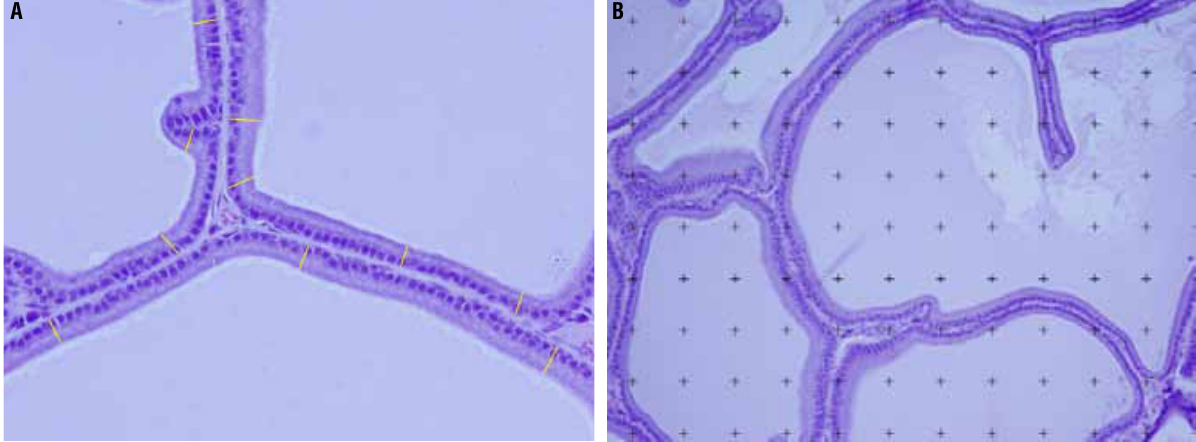
Figure 1 - Photomicrographs of the rat prostate ventral lobe showing the morphometric features. A) The height of the acinar epithelium (yellow) was measured in micrometers in photomicrographs of 400x magnification using the Image J software. HE x400. B) The surface density of ventral lobe prostate lumen, epithelium and stroma were estimated by the point intercepts